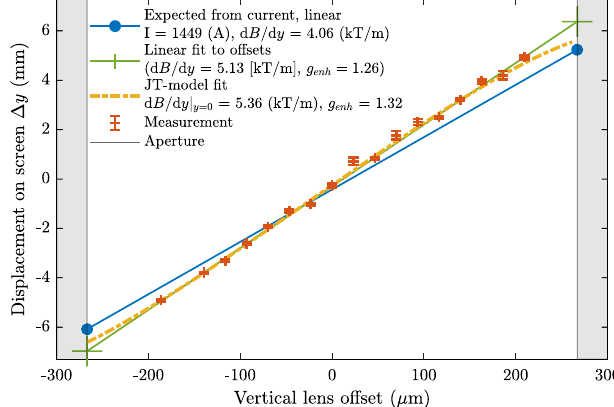
FIG. 5. Estimated gradient enhancement as a function of time at a fixed offset ( y 0 ¼ − 150 μ m) in argon. The result from the offset scan shown in Fig. 6 is also indicated.